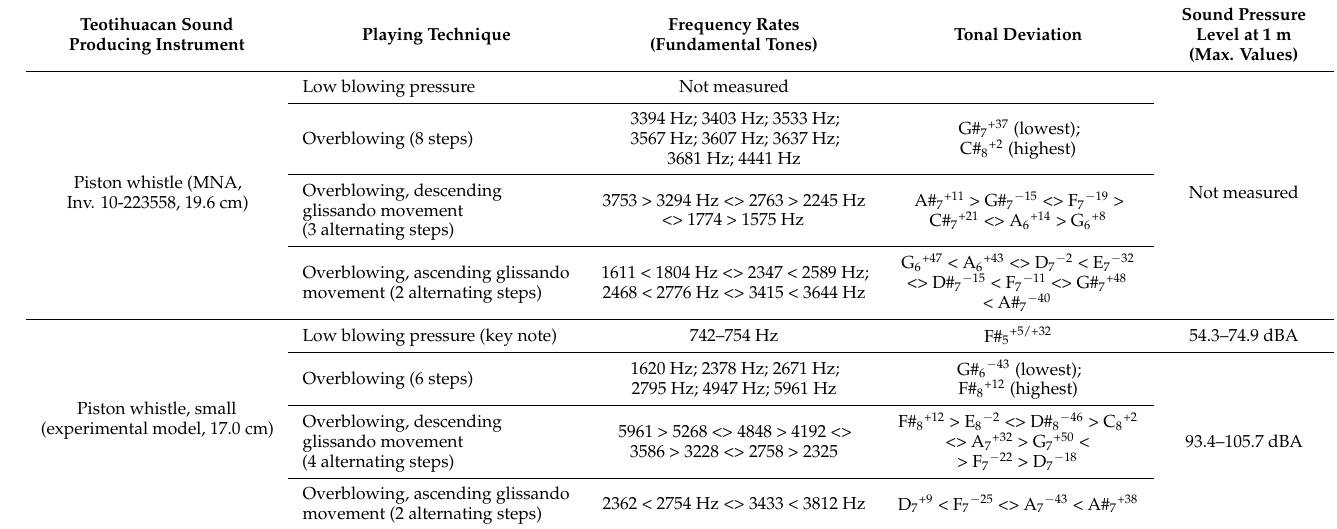
Table 6. Acoustic data sheet of the documented piston